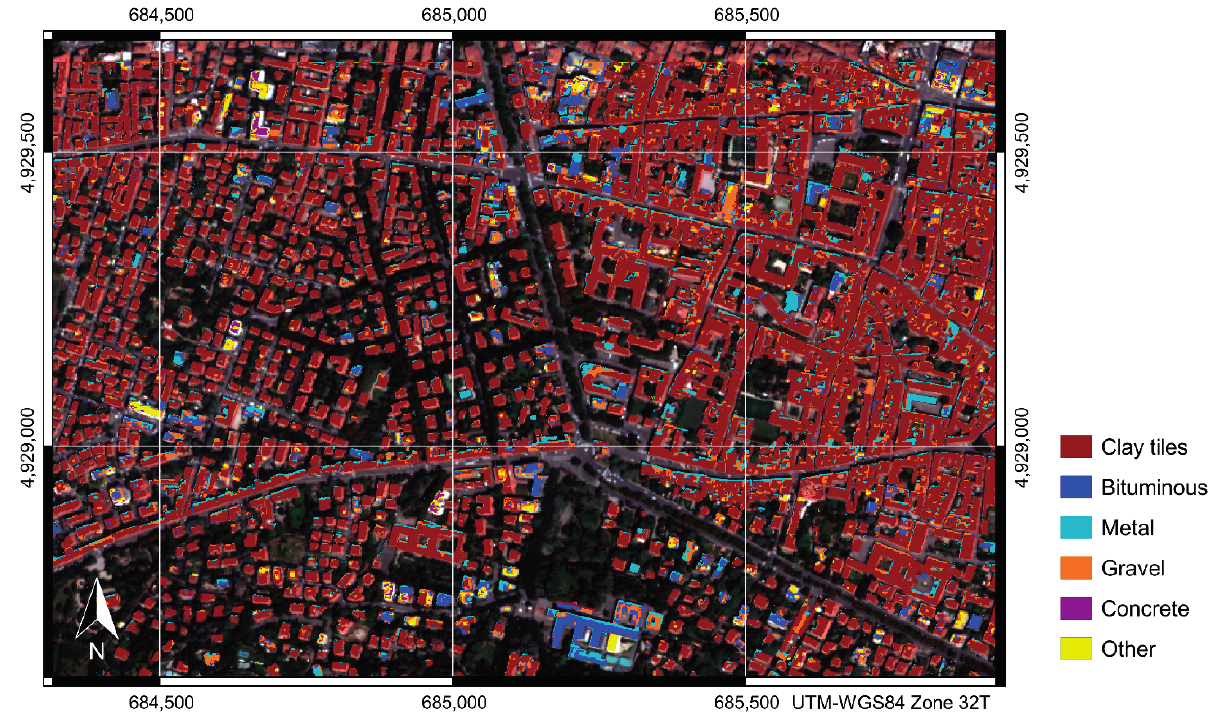
Figure 6. The final classification of the roofing materials of a portion of Bologna, obtained by a supervised object-oriented classification, applied on a WorldView-2 multispectral image together with digital elevation